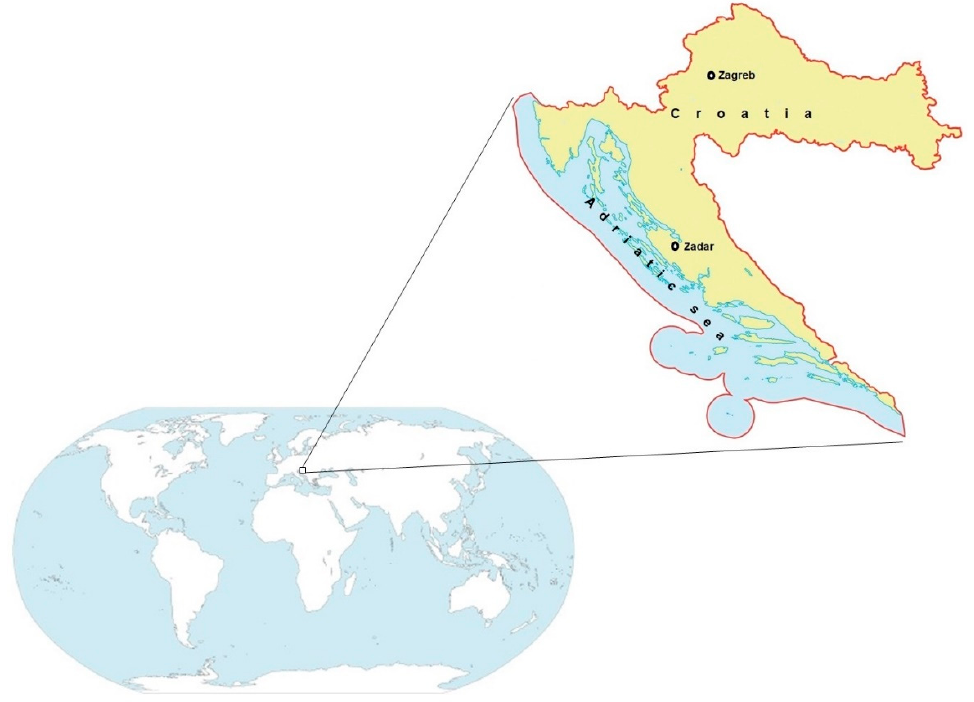
Figure 1. Location of the residence areas of recruited mother–infant pairs in Croatia.